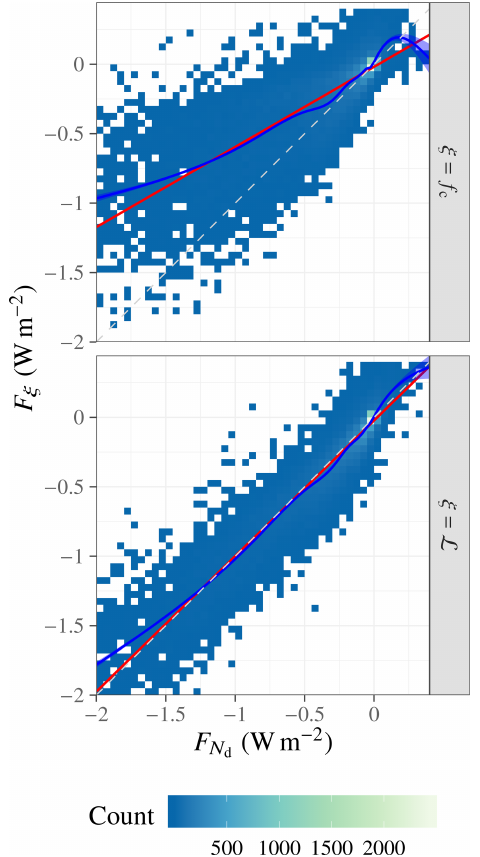
Figure 5. Correlation plots between the temporal-mean Twomey forcing and the adjustments; color indicates the number of grid boxes within each 0 . 05Wm − 2 × 0 . 05Wm − 2 bin; the red line is a linear least-squares regression; the blue line is a generalized addi- tive model regression (Wood, 2011), with 95% confidence interval shaded in light blue; and the dashed gray line is the one-to-one